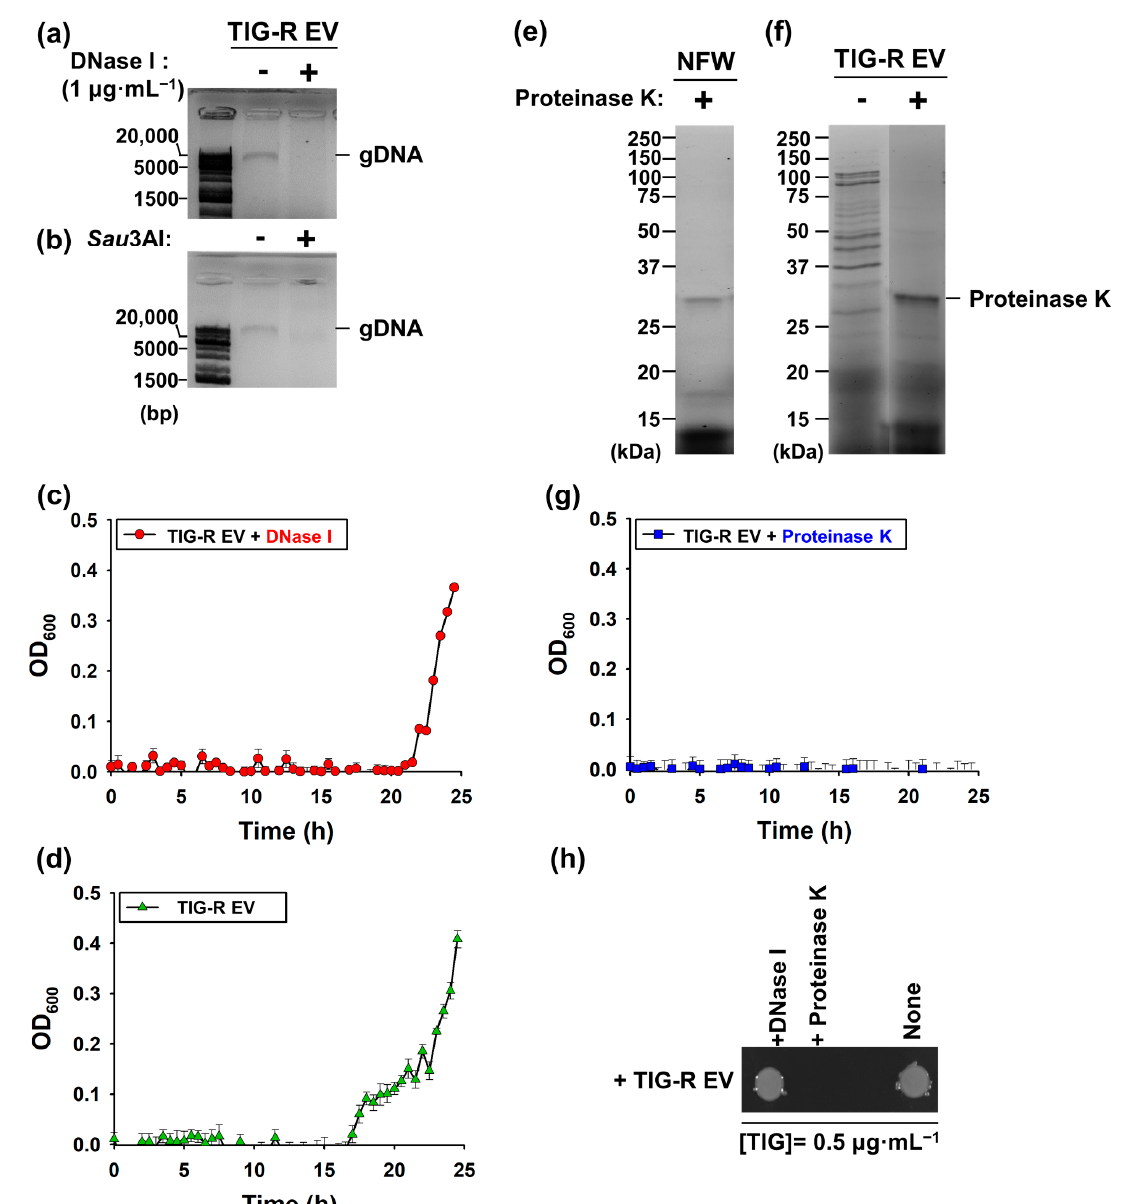
Figure 3. Identification of determinants for the TIG transfer activity. Degradation of DNA compo- nents by DNase or restriction enzyme. TIG-R EV components. TIG-R EVs were treated with ( a ) DNase I and ( b ) Sau 3AI. TIG-R EVs added with DNase I, Sau 3AI were observed by 1% agarose gel elec- trophoresis with 1 kb Plus DNA Ladder (Thermo Fisher Scientific, Waltham, MA, USA). Growth curve analysis of TIG-S AB (ATCC 17978) strain with TIG-R EVs (5 µ g) pre-treated with ( c ) DNase I (Red, circle), ( d ) NFW (Green, up-triangle), and ( g ) proteinase K (Blue, square) under TIG (0.5 µ g · mL − 1 ). Cell growth (OD 600 ) was monitored by SPECTROStar ® Nano (BMG LABTECH GmbH, Ortenberg, Germany, n = 3). ( e , f ) Characterization of proteins from TIG-R EVs after proteinase K treatment. EV proteins and proteinase K were identified using 12% Mini-PROTEAN®TGX TM Stain-Free gels (Bio-Rad, Hercules, CA, USA) with Precision Plus Protein TM Standards (Bio-Rad, Hercules, CA, USA). Images ( a , b , e , f ) were obtained by ChemiDoc TM MP Imaging System (Bio-Rad, Hercules, CA, USA) and Image Lab Software (ver.5.2.1, Bio-Rad, Hercules, CA, USA). ( h ) Cell viability. Aliquots of cells from ( c , d , g ) were spotted after growth for 16 h. All images ( a , b , e , f , h ) were obtained by ChemiDoc TM MP Imaging System (Bio-Rad, Hercules, CA, USA) and Image Lab Software (ver.5.2.1, Bio-Rad, Hercules, CA,